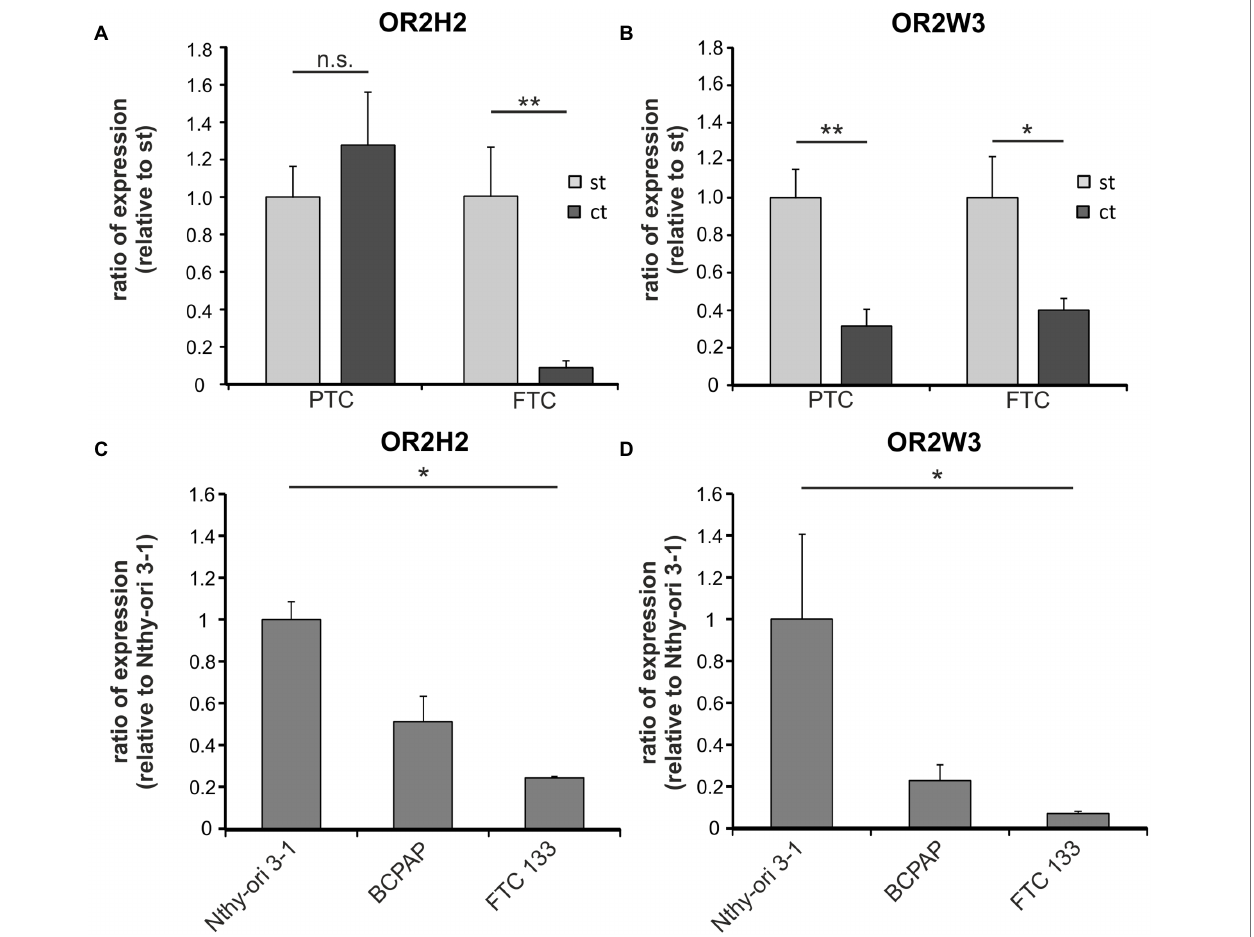
FIGURE 1 | Expression of OR2H2 and OR2W3 in human thyroid tissues and cell lines. (A,B) Detection of OR2H2 and OR2W3 mRNA in human tissues of papillary thyroid carcinoma (PTC n = 8) and follicular thyroid carcinoma (FTC n = 8). Cancer tissue (ct) was compared to normal surrounding tissue (st) via quantitative RT- PCR. (C,D) mRNA expression level of OR2H2 and OR2W3 in Nthy-ori 3-1, BCPAP, and FTC 133 cell lines determined by quantitative RT-PCR ( n = 3). The expression of OR2H2 and OR2W3 in FTC 133 and BCPAP was compared to Nthy-ori 3-1 cells. The mean values are shown with the corresponding SEM. Mann- Whitney-U-Test used to compare surrounding and malign tissues, while Kruskal-Wallis test with post hoc “Two-stage step-up method of Benjamini, Krieger, and Yekutieli” was used to compare expression levels between the cell lines: * p ≤ 0.05 and ** p ≤ 0.01; n.s. = not